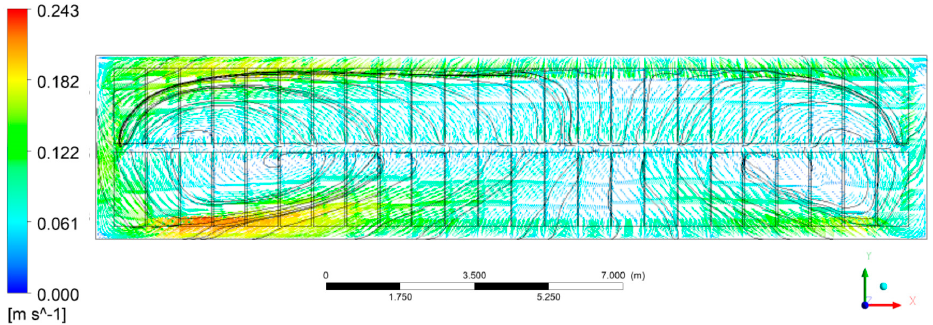
Figure 11. Velocity vectors of the bath flow in the middle horizontal plane of ACD (Case 2).